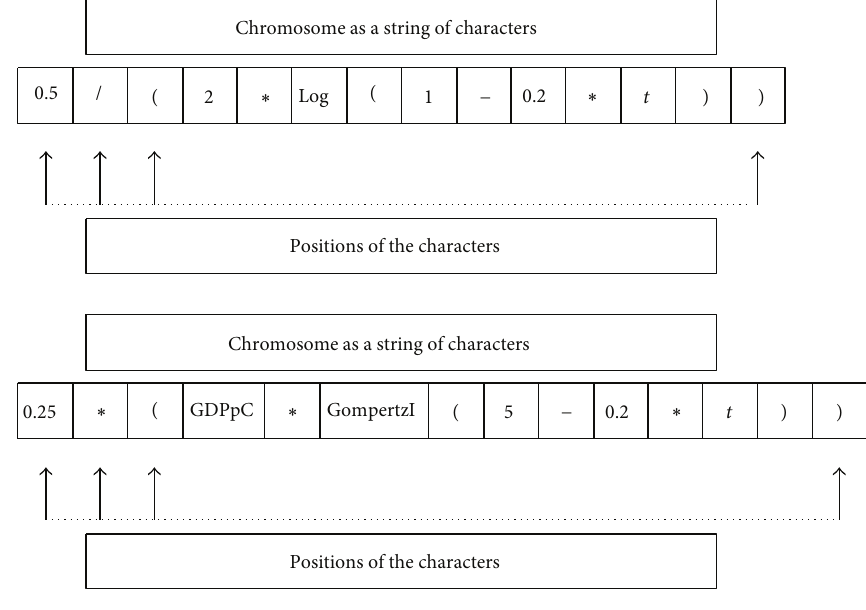
Figure 2: Representation of chromosomes in modified hGP as strings.